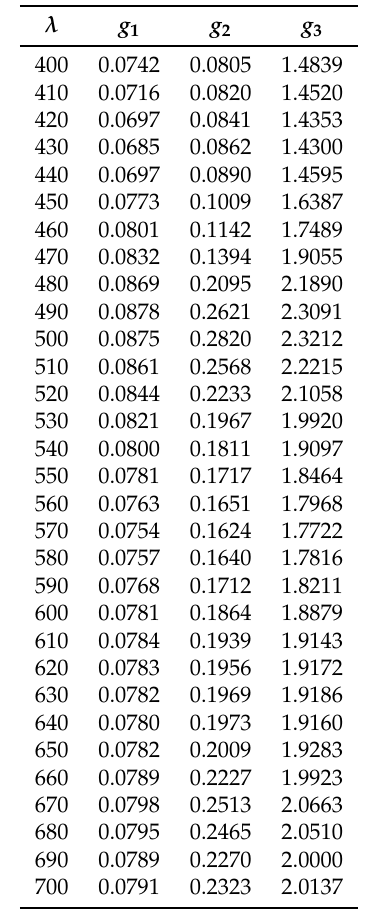
Table A8. g coefficients used in Equation (11) after performing linear interpolation to the necessary wavelengths.